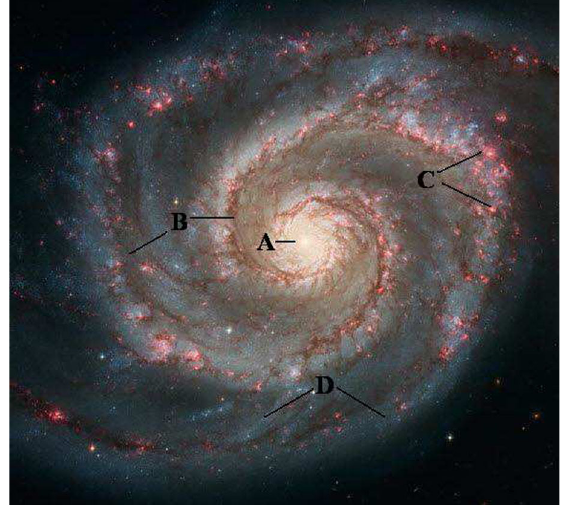
FIG. 3. Spiral Galaxy. Following open-ended questions were asked: This is a galaxy imaged by the Hubble Space Telescope. WhatistheyellowishareaAinthephoto?Whatcausesittohavethis appearance?; What are the dark features B? What causes them to have this appearance?; What are the reddish blotches C? What causes them to have this appearance?; What are the pale blue areas D? What causes them to have this appearance?; and, In the galaxy image, why do you think this object has the structure it